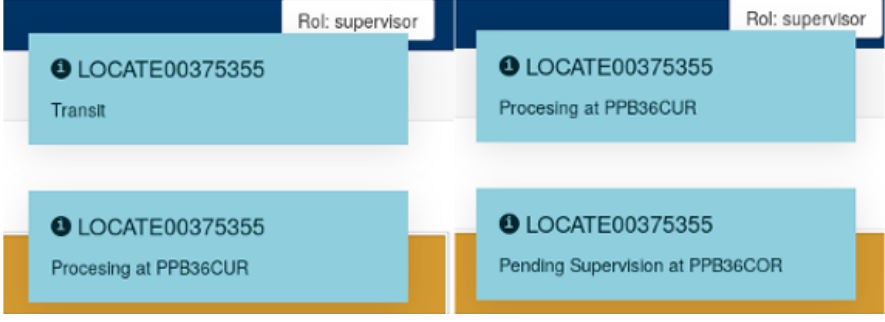
Figure 14. Event notifications on the display